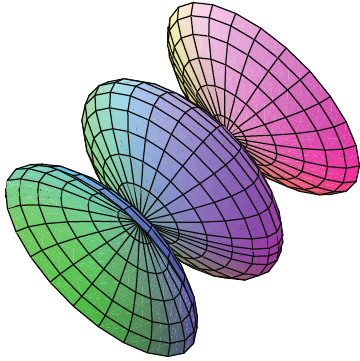
Figure 1: The catenoid of the 1st kind.